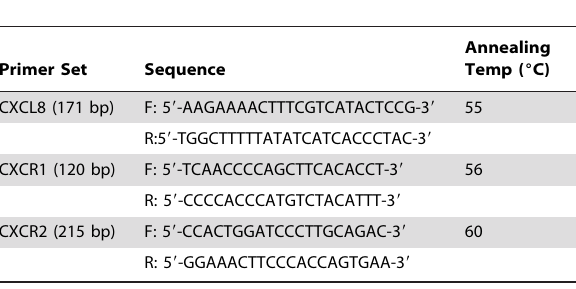
Table 1. Primers and annealing temperatures for RT-PCRs. Table 2. Primers and annealing temperatures for